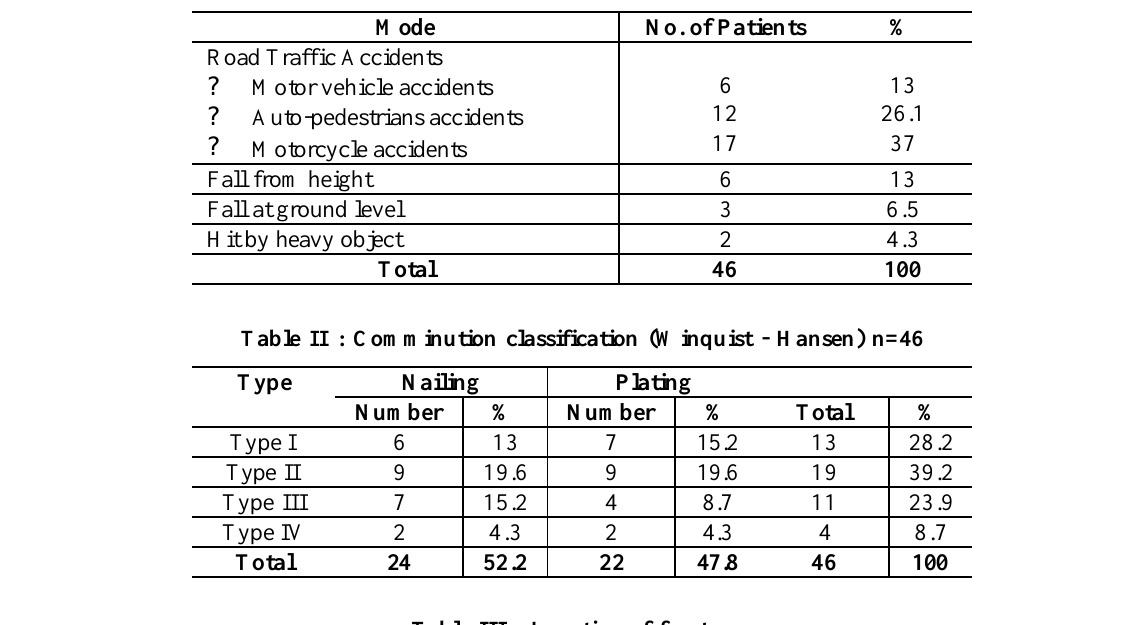
Table III : Location of fractures